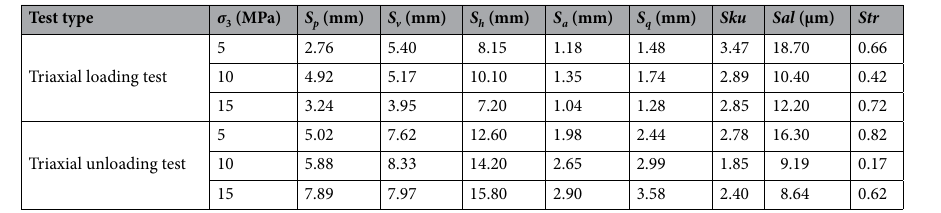
Table 6. Three-dimensional morphological parameters of argillaceous sandstone fractured